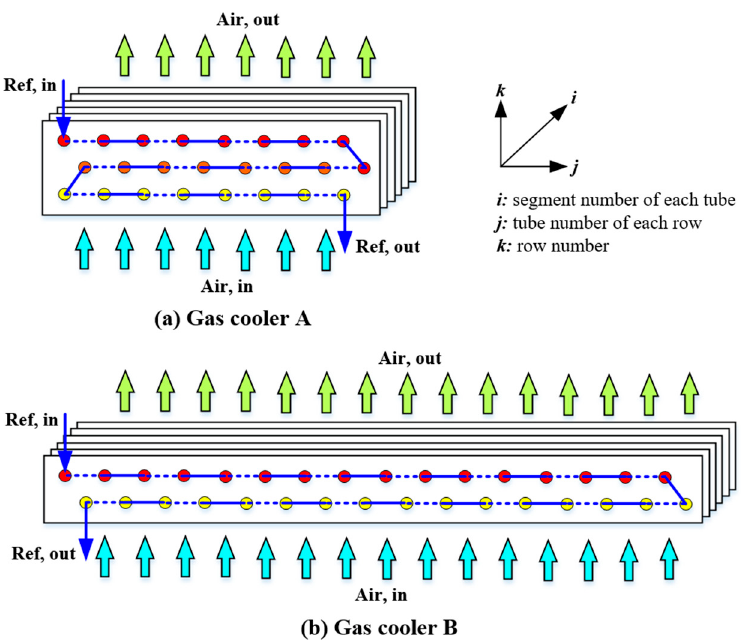
Figure 1. Models of finned-tube sCO 2 gas coolers: ( a ) gas cooler A and ( b ) gas cooler B.